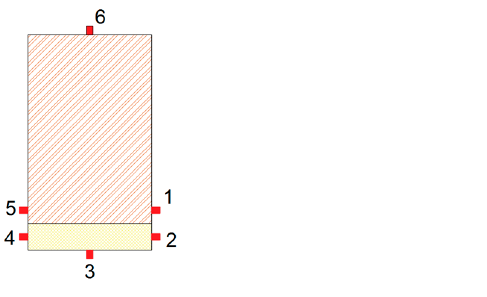
Figure 2. Location of the strain gauges along the mid-cross section of the reinforced beams.